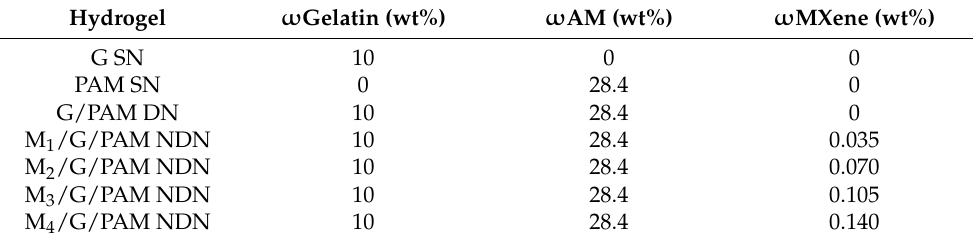
Table 1. The proportioning parameters of G SN hydrogel, PAM SN hydrogel, G/PAM DN hydrogel, and M/G/PAM NDN